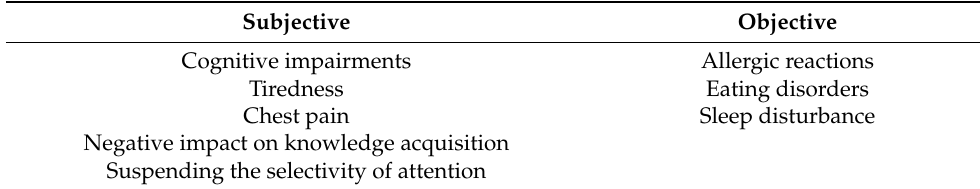
Suspending the selectivity of